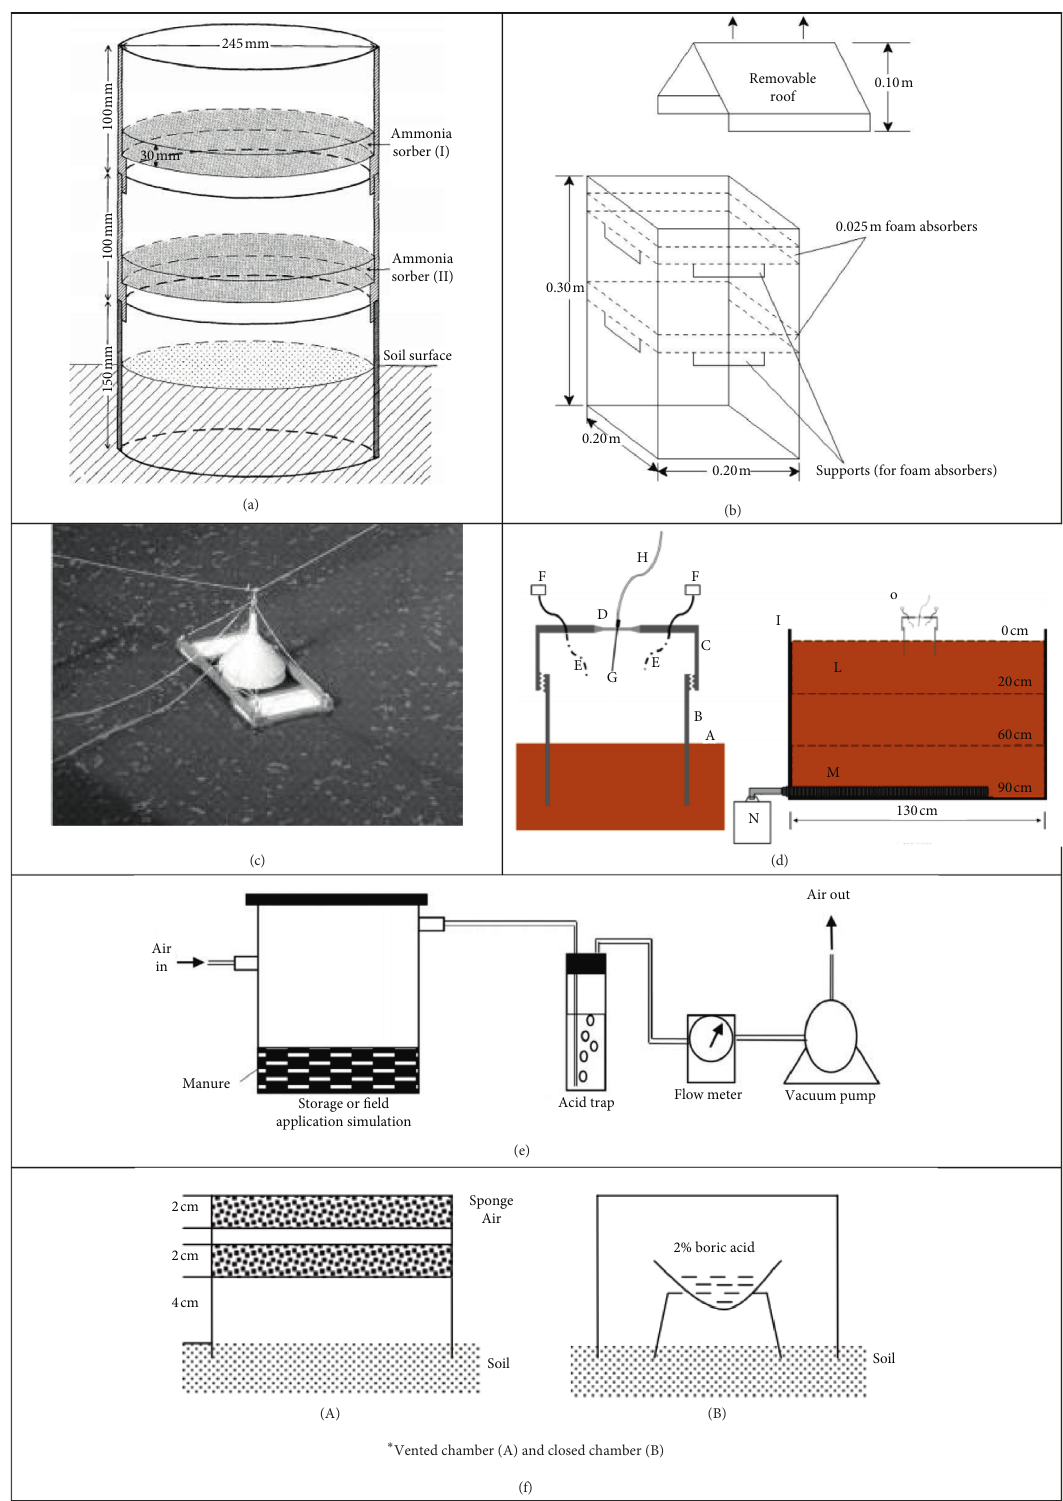
Figure 2: Some of the different chamber methods found in the literature. (a) Nˆommik [36]. (b) Smith et al. [37]. (c) Balsari et al. [38]. (d) Verdi et al. [39]. (e) Ndegwa et al. [40]. (f) Wang et al.